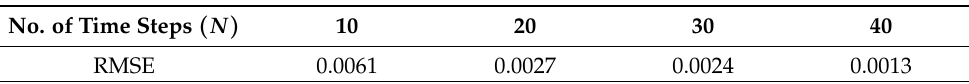
Table 5. The accuracy of the proposed Best-Fit model for pricing European call options under the Heston SV